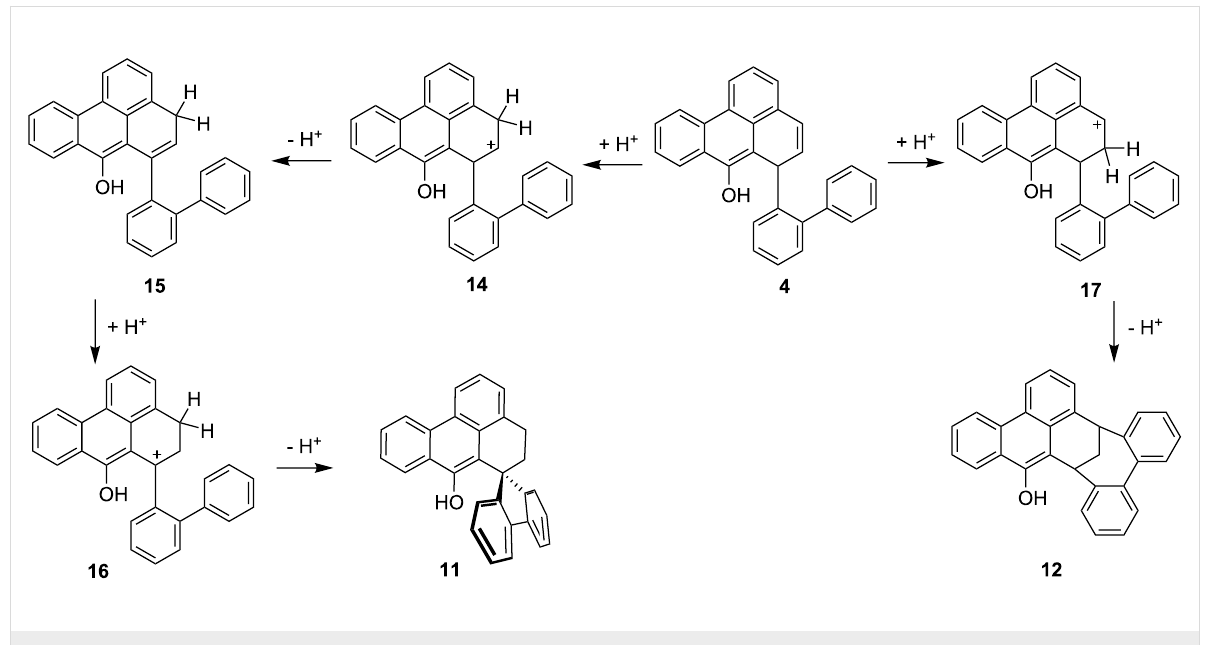
Scheme 4: Proposed mechanism for the formation of spiro compound 11 and bicyclo[4.3.1]decane derivative 12 .